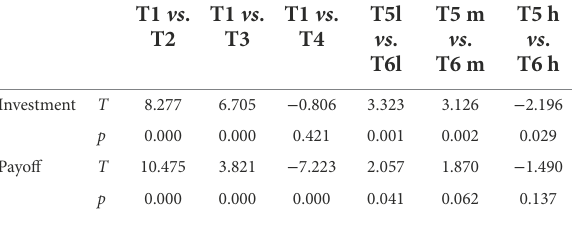
TABLE 3 The t -test of individual investment and payoff.